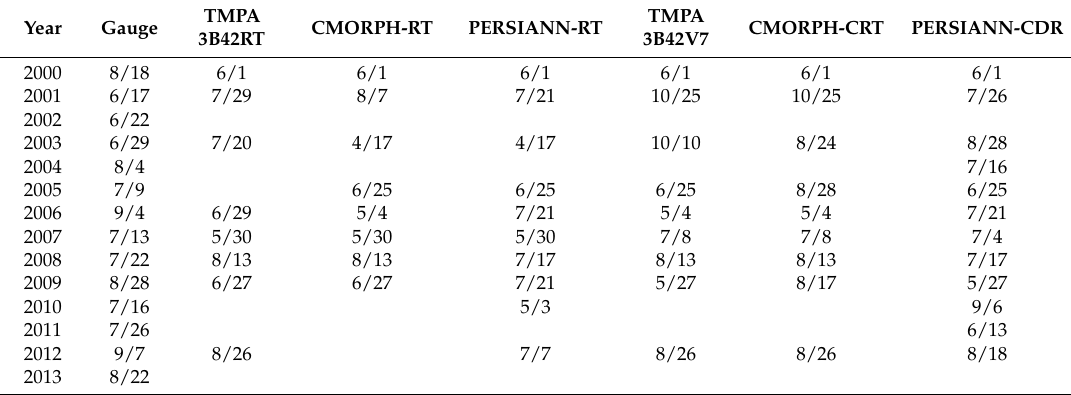
Figure 3. Box plots of the BIAS index of the annual maximum ( a ) 1-day precipitation; ( b ) 3-day precipitation and ( c ) 5-day precipitation for the six SPPs versus rain gauge observations over 14 years. The upper and lower edges of the box mark the upper and lower quartiles (75% and 25%, respectively); the solid line in the box marks the median value; the upper and lower horizontal lines out of the box mark the 90% and 10% quartiles, respectively; the points mark the maximum and minimum values. Table 5. Occurrence date of annual maximum 1-day precipitation (R × 1 d) detection by rain gauge observations and six SPPs for the period of 2000–2013. Gray boxes indicate the date of R × 1 d detected by SSPs is consistent with the date detected by rain gauge